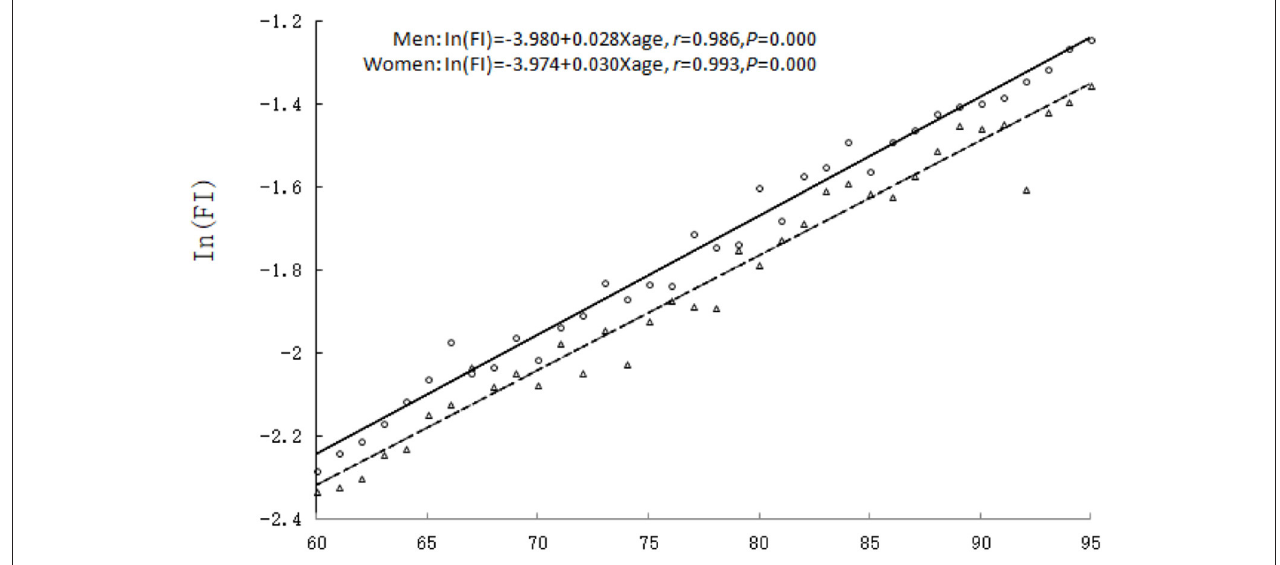
FIGURE 1 | The relationship between age and the mean value of FI. Men: triangle and dashed line; women: circles and solid line.